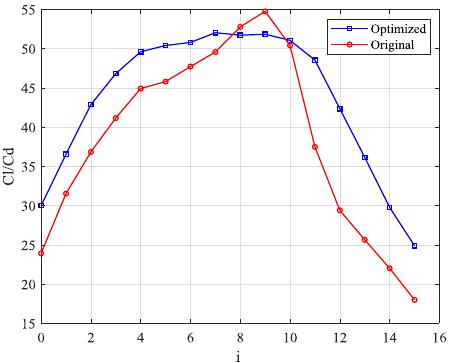
= 1.0 × 10 5 , Ma = 0.1). Figure 9. Airfoil performance of the average lift-drag ratio (cal.,  ). Figure 9. Airfoil performance of the average lift-drag ratio (cal., Re Figure 9. Airfoil performance of the average lift-drag ratio (cal., 5 Re 1.0 10 , 0.1 Ma = × = ). For further analysis, CFD simulation software CFX was used to calculate the cascade performance. ◦ ◦ The velocity contours of the original and optimized cascades at incidence angles of i = 0 and i = 12 are shown in Figure 10. It is clear that the velocity difference between the suction side and pressure side of the optimized cascade is bigger than that of NACA4412. Therefore, the diffusion factor D of the optimized cascade can be increased. It can also be observed that the airflow separation point on the suction side of the optimized cascade moves backward along the airfoil in comparison with that of NACA4412 and the area of the wake becomes smaller than that of NACA4412. Therefore, it can